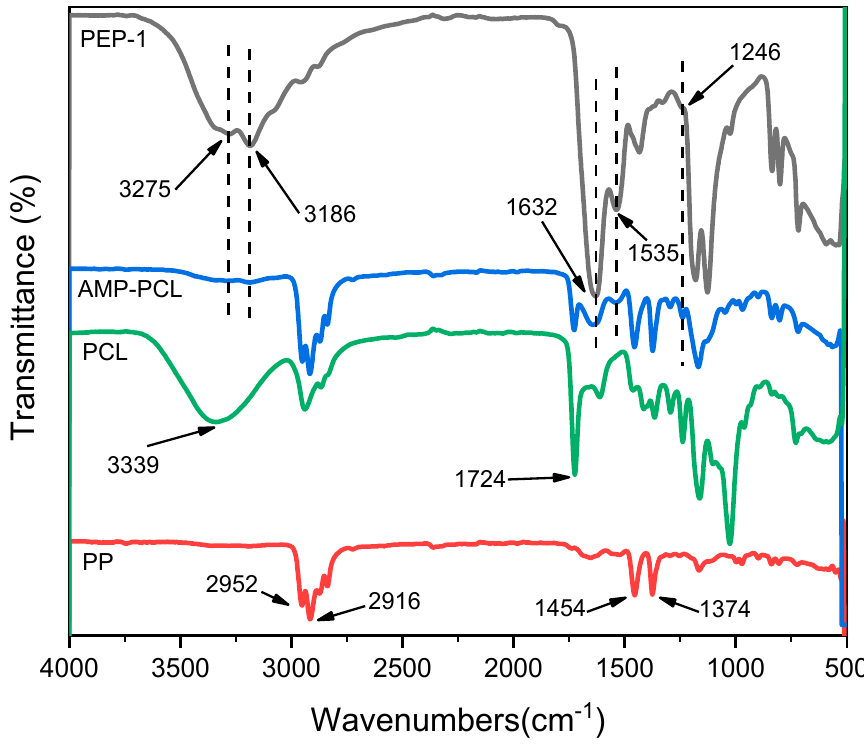
Figure 2. Fourier transform infrared spectra of fabricated scaffolds and original samples.